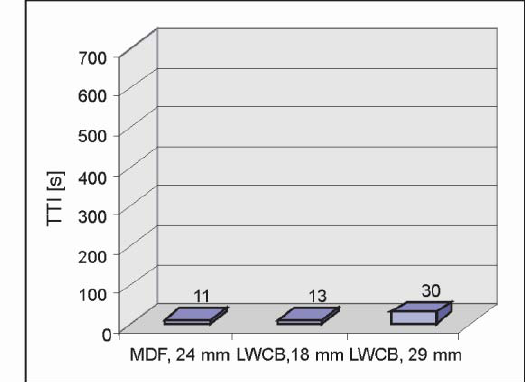
Fig. 2. Mean time to ignition (TTI) when exposed to the surface heat flow density of 30 kW/m 2 for different tested boards